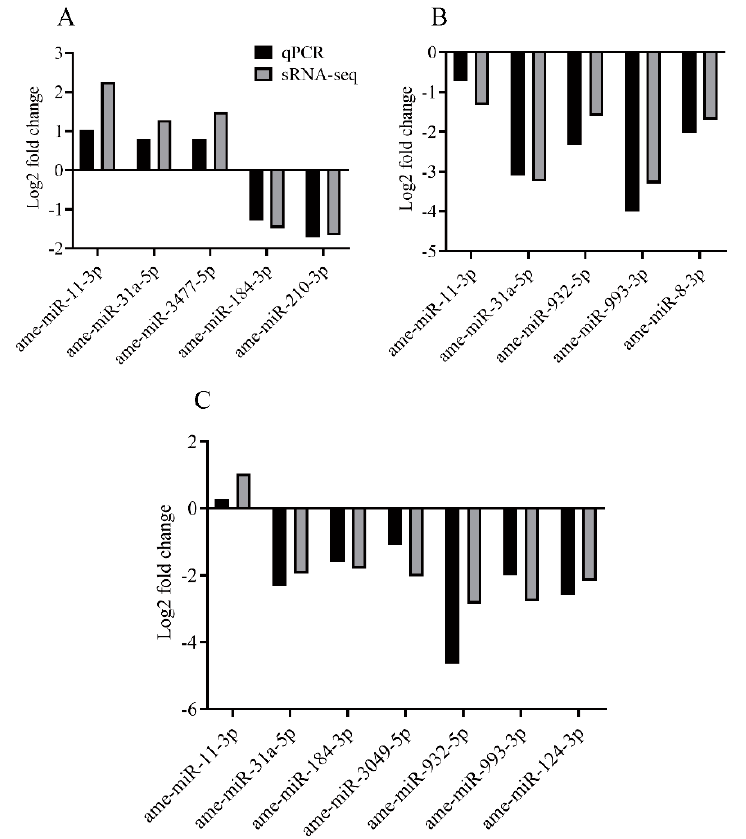
Figure 6. Validation of differentially expressed miRNAs confirmed in the NB vs. FB comparison ( A ), the FB vs. NEB comparison ( B ), and the NB vs. NEB comparison ( C ) by qPCR analysis. NB: nurse bee, FB: forager bee, NEB: newly-emerged bee.